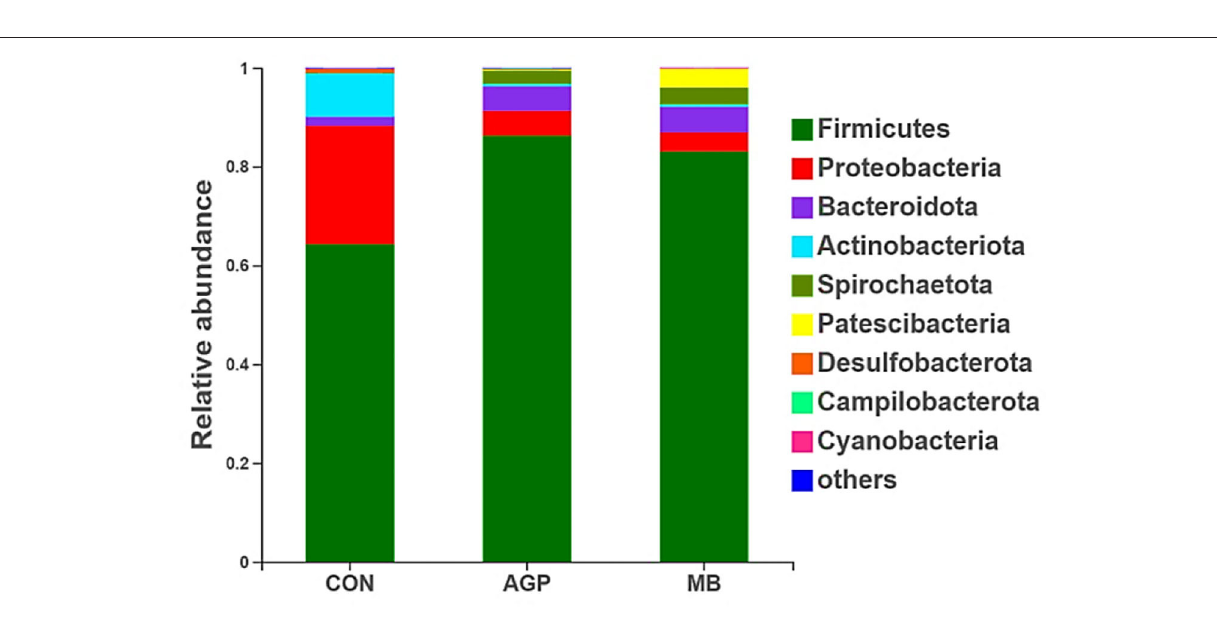
FIGURE 4 | Relative abundance of intestinal bacteria based on the Phyum level. CON, basal diet; AGP, basal diet + 20 mg/kg flavomycin + 50 mg/kg quinocetone; MB, basal diet + 50 mg/kg Macleaya cordata extract + 1,000 mg/kg benzoic